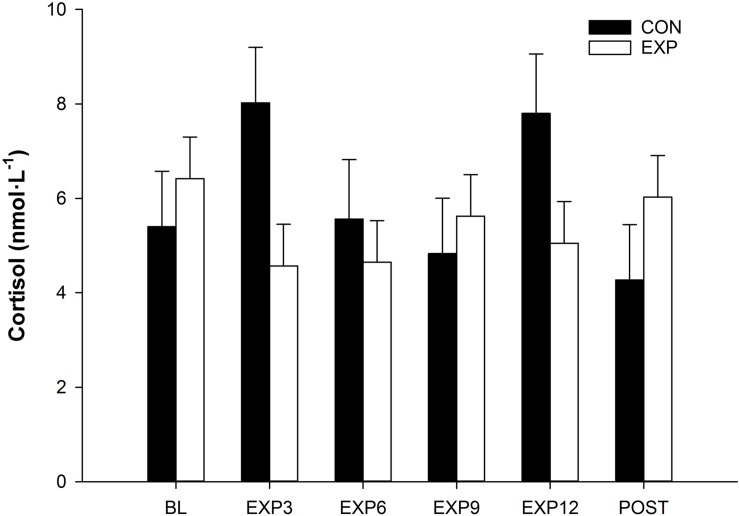
Saliva cortisol concentration values for CON and EXP group at baseline (BL), three in expedition (EXP3), 6 days in expedition (EXP6), 9 days in expedition (EXP9), 12 days in expedition (EXP12), and post expedition (POST). Means ± SEM.